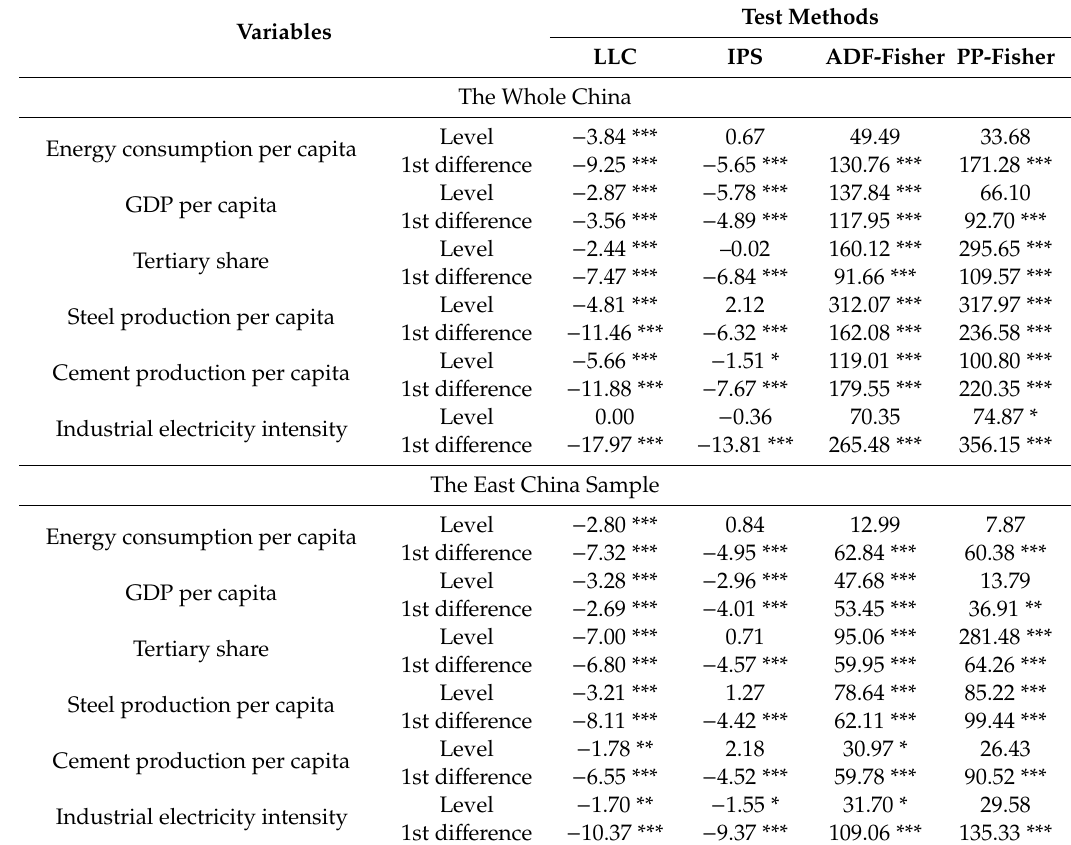
Table 3. Results of panel unit root